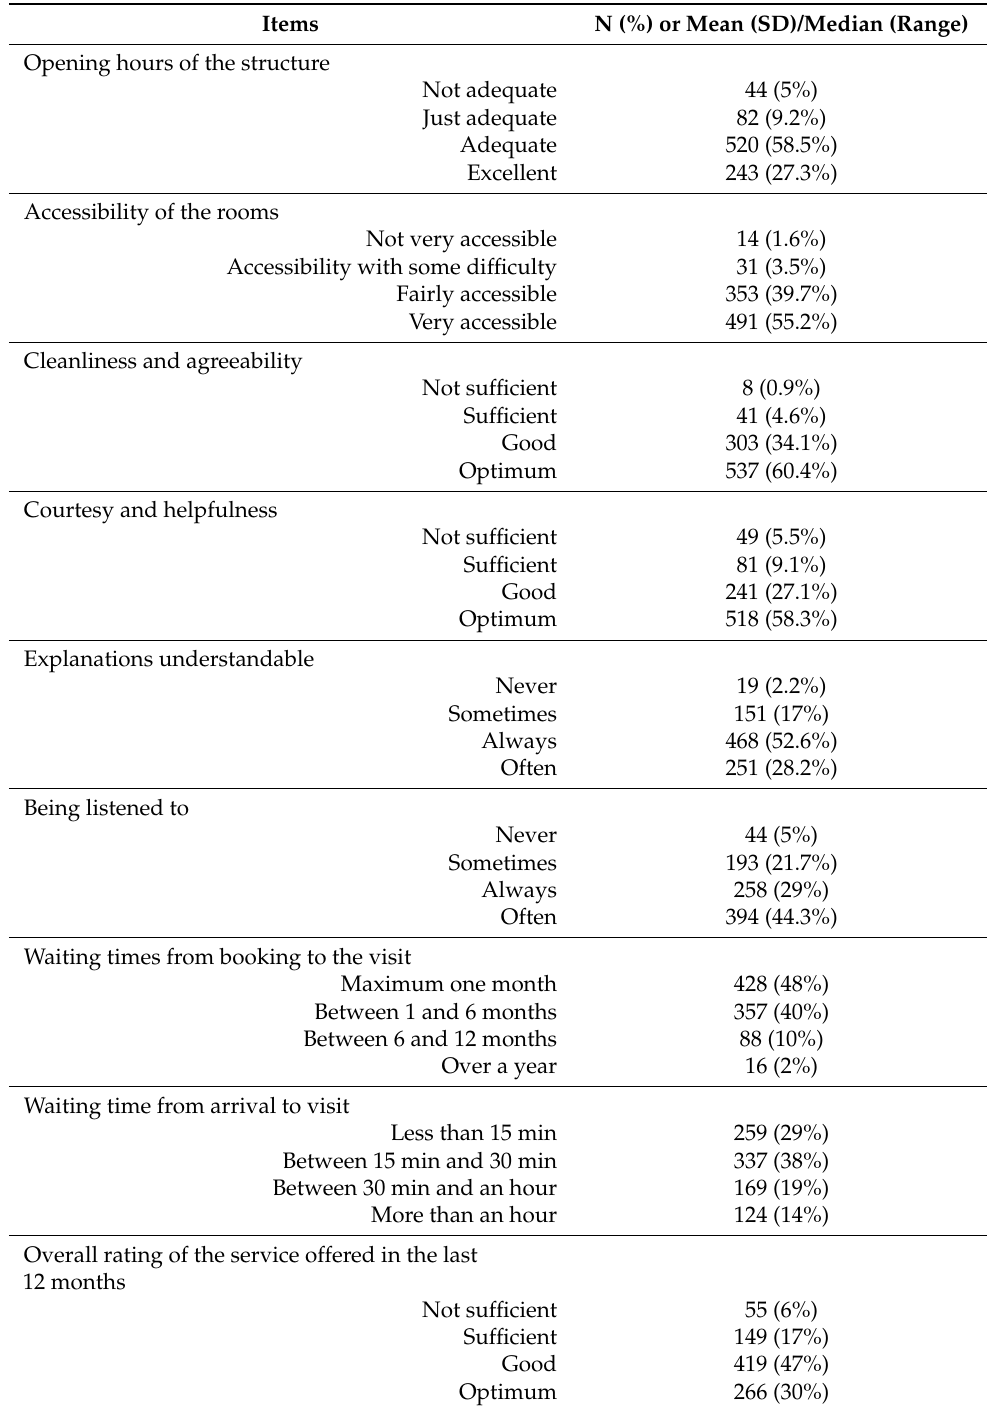
Table 3. Quality health care perception (women who had a medical visit for endometriosis in the last 12 months, n =